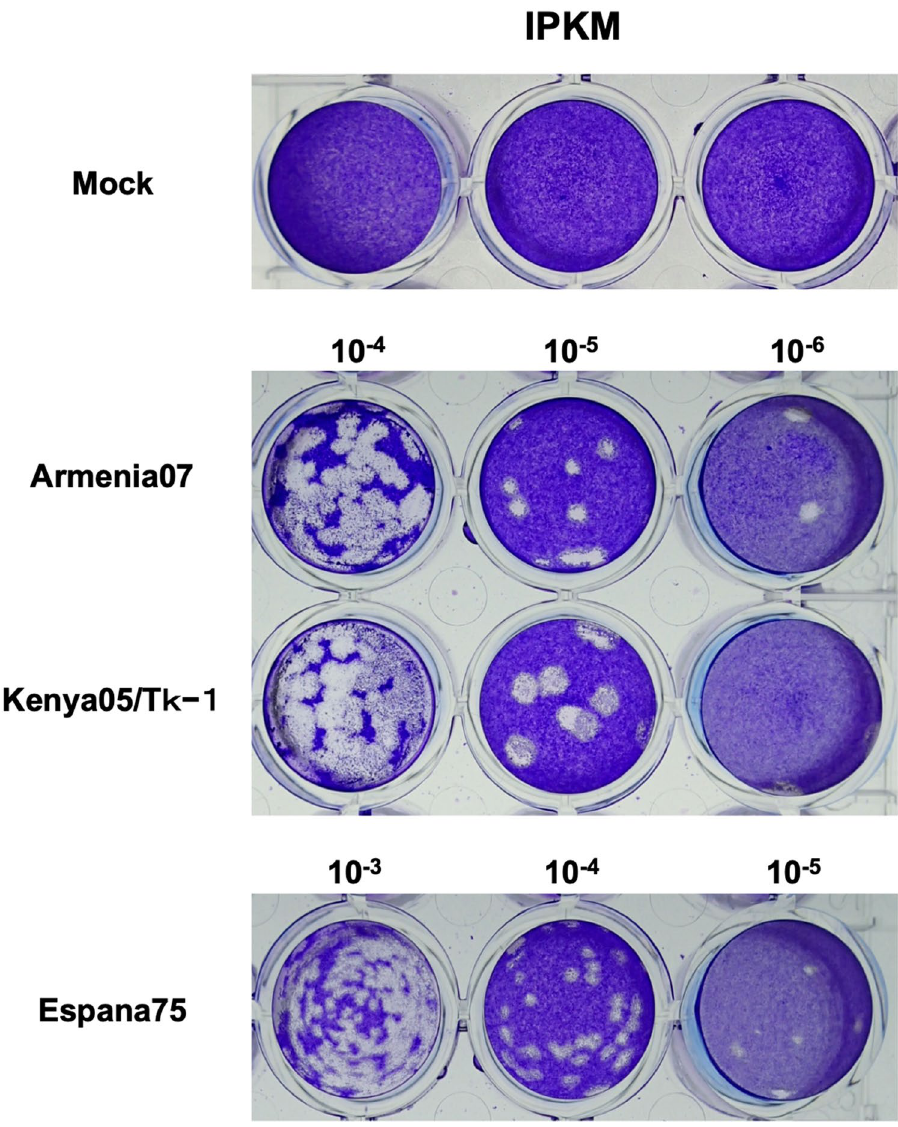
Figure 5. Plaque assay of African swine fever virus (ASFV) in immortalized porcine kidney macrophages (IPKM). IPKM cells cultured in 24-well cell culture plates were inoculated with tenfold dilutions of ASFV isolates (Armenia07, Kenya05/Tk-1 and Espana75), overlaid with agar medium and incubated, before staining with crystal violet.